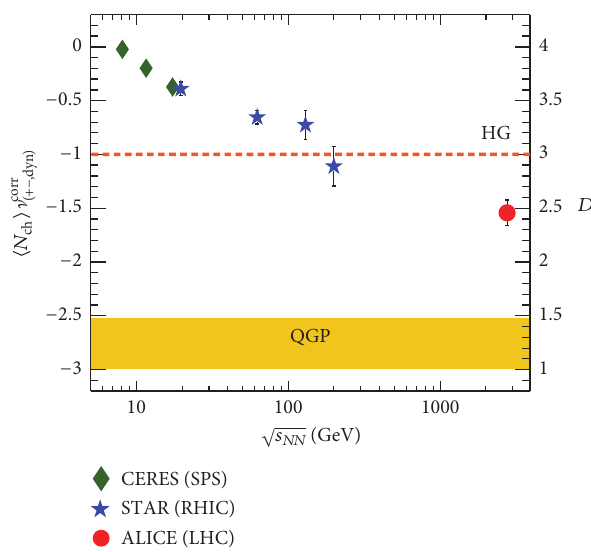
Figure 5: Energy dependence of net-charge fluctuations about midrapidity in central heavy-ion collisions at SPS [52], RHIC [51], and LHC [53] energies. Also shown are the expectations from a hadron resonance gas model and for a simple QGP picture [22]. The combined (statistical and systematic) errors are plotted along with the data